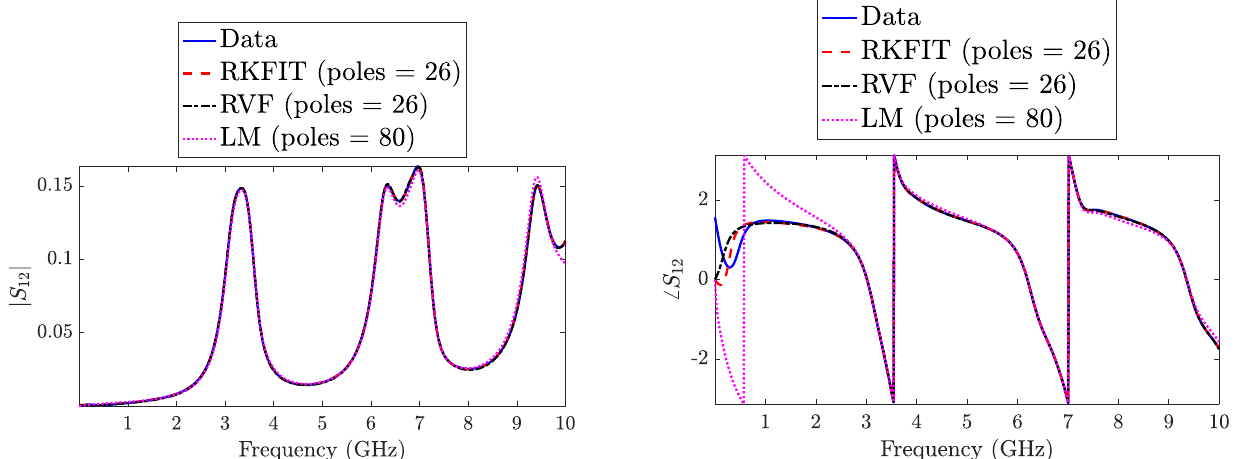
Figure 8. Comparison of RKFIT with RVF and LM models with given data for S 12 of Section 3.2.